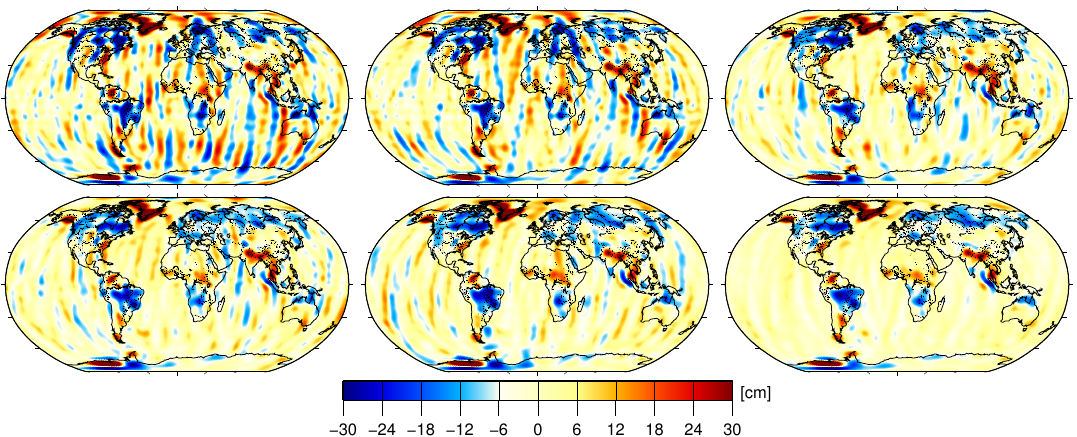
Figure 9. Gravity field anomalies in terms of cm EWH (DDK3 filtered) for the month 2003/08 for all GFZ GRACE releases so far: RL01 ( top left ), RL02 ( top middle ), RL03 ( top right ), RL04 ( bottom left ), RL05a ( bottom middle ), and RL06 ( bottom right